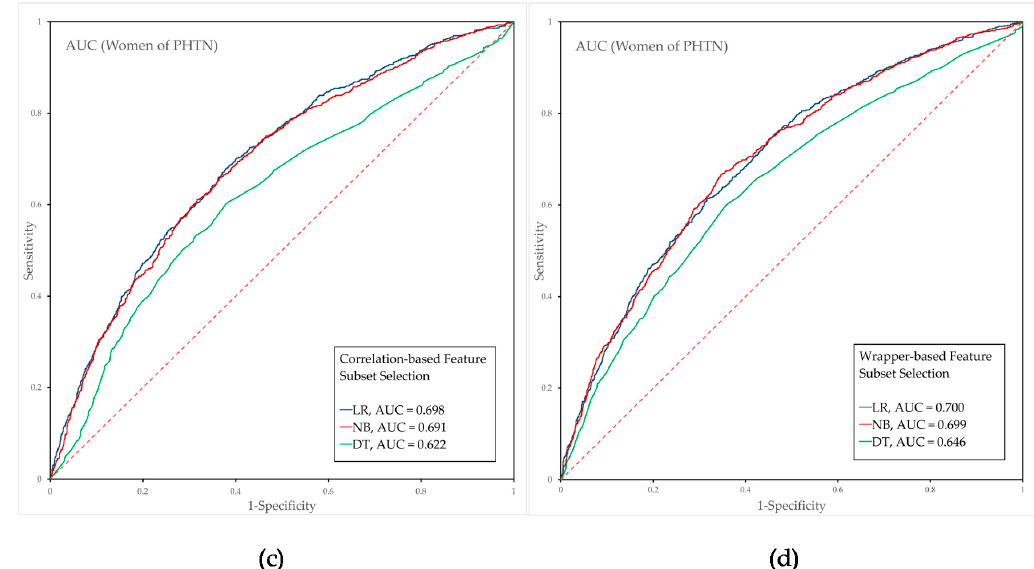
Figure 2. Predictive power of each prehypertension prediction model for men and women. Each graph presents the results for the LR, NB, and DT algorithms. ( a , b ) present the results for men, and ( c , d ) present the results for women. ( a , c ) show the results obtained with CFS, and ( b , d ) show the results obtained with WFS. Abbreviations: LR, logistic regression; NB, naïve Bayes; DT, decision tree; AUC, area under the receiver operating characteristic curve; PHTN, prehypertension; CFS, correlation-based Feature selection; WFS, wrapper-based feature selection.